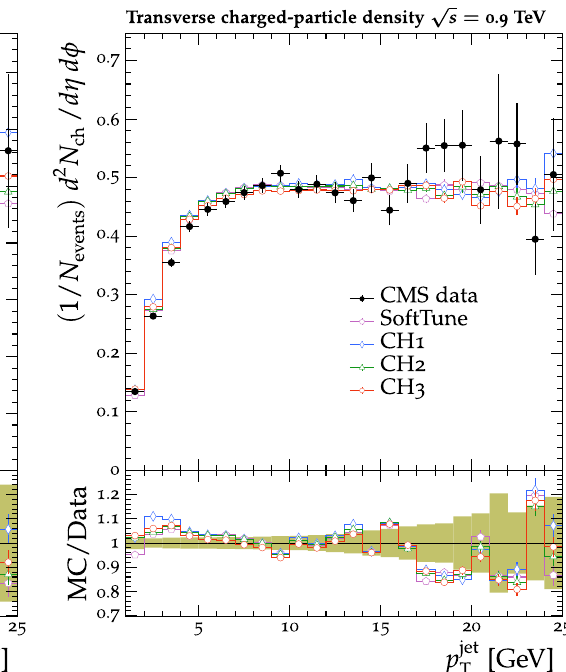
Fig. 5 The p sum (left)and N ch (right)densitydistributionsinthetrans- T verse regions, as a function of the p T of the leading track jet, p jet CMS MB data are compared with the predictions from herwig 7, with the SoftTune and CH tunes. The coloured band in the ratio plot repre-